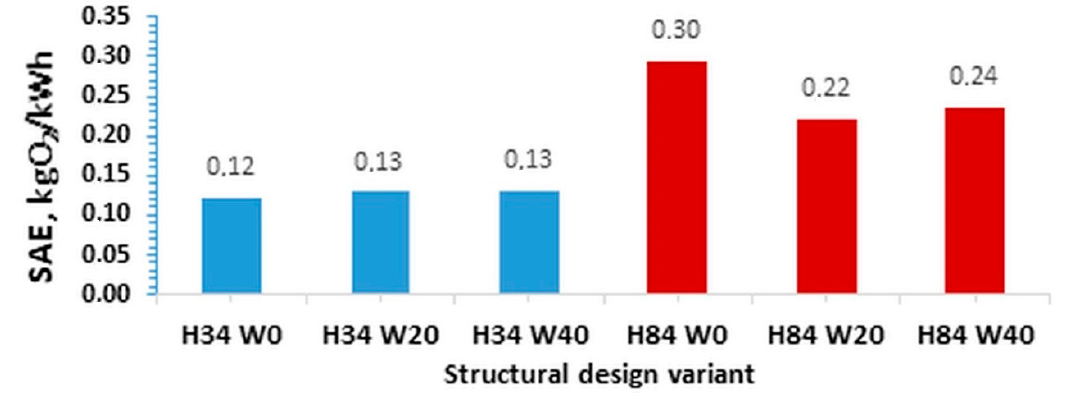
Figure 13. Standard oxygen transfer efficiency (SOTE) in the tested barbotage reactor.